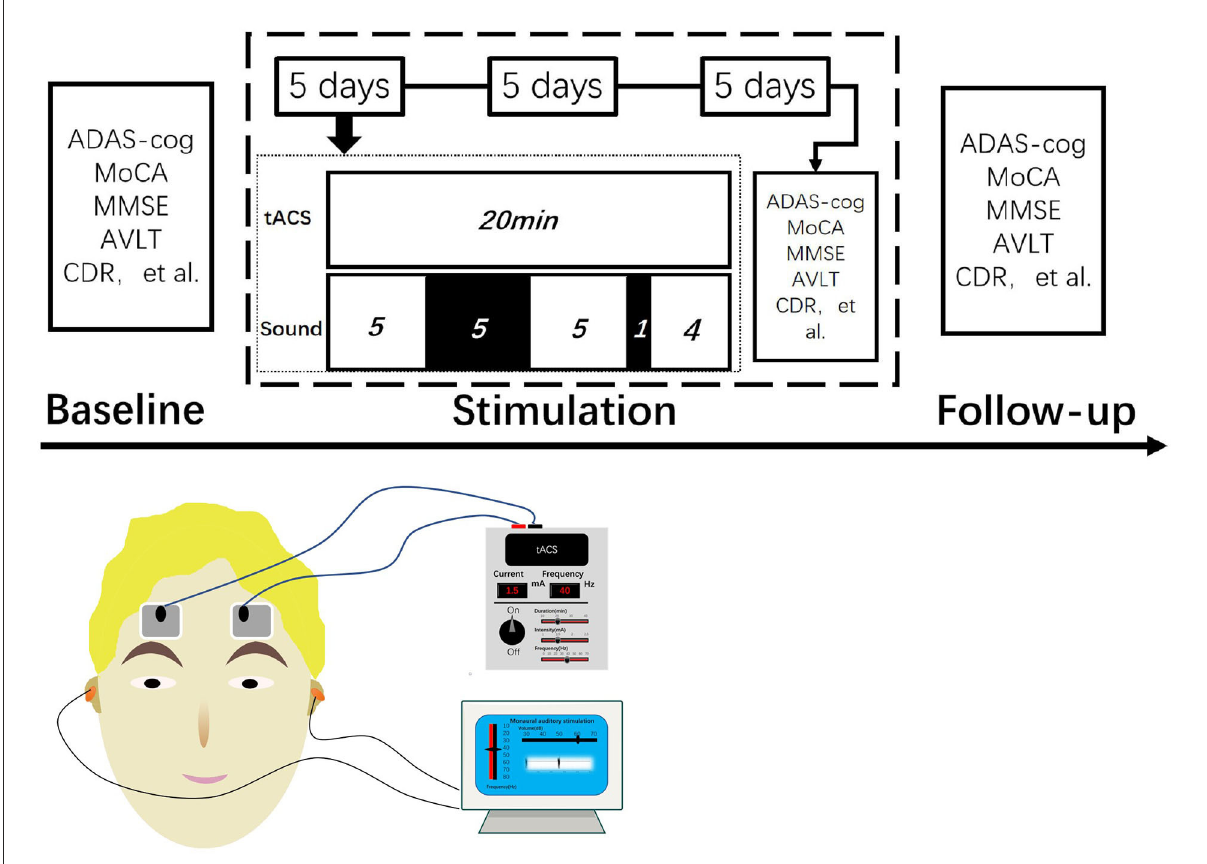
FIGURE1 Test process and stimulus